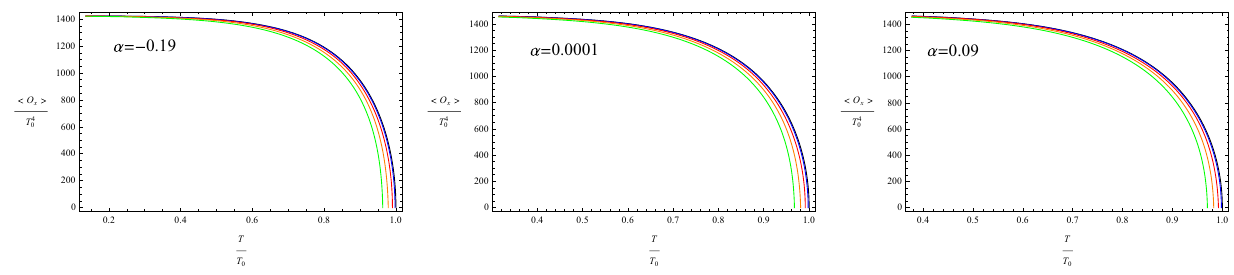
increasing superfluid velocity, i.e., K = qS y / r + = 0 (black), 0 . 25 (blue), 0 . 50 (red), 0 . 75 (orange) and 1 . 00 (green), respectively. We scale q = 1 and r + = 1 in the numerical